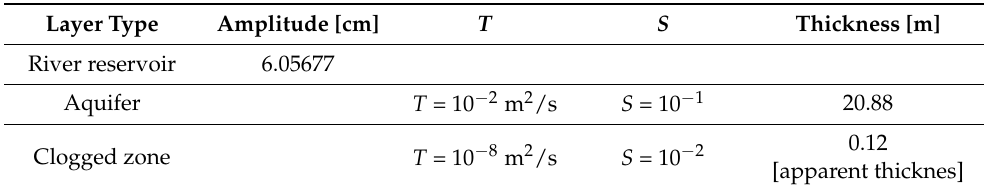
Table 3. Input data for analysis carried out by the hydraulic method, and thickness at which there is best fitting.